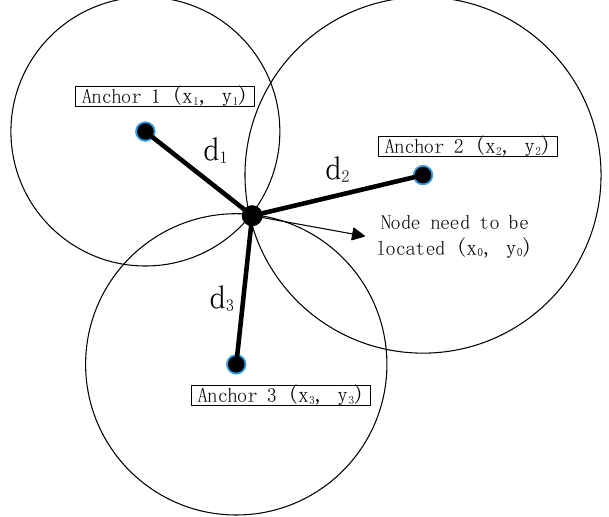
Figure 2. Process of trilateration.